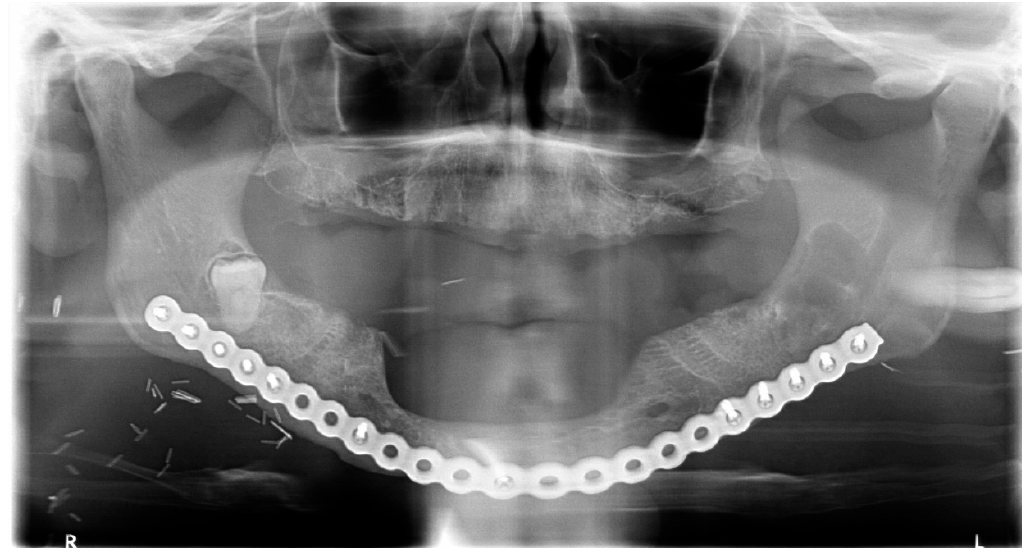
Figure 13. CBCT X-ray of case 4 at one year follow-up.